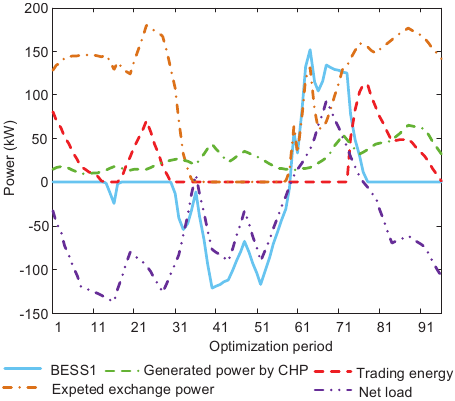
Figure 24. The optimal variables and net load in MG1 in Scenario